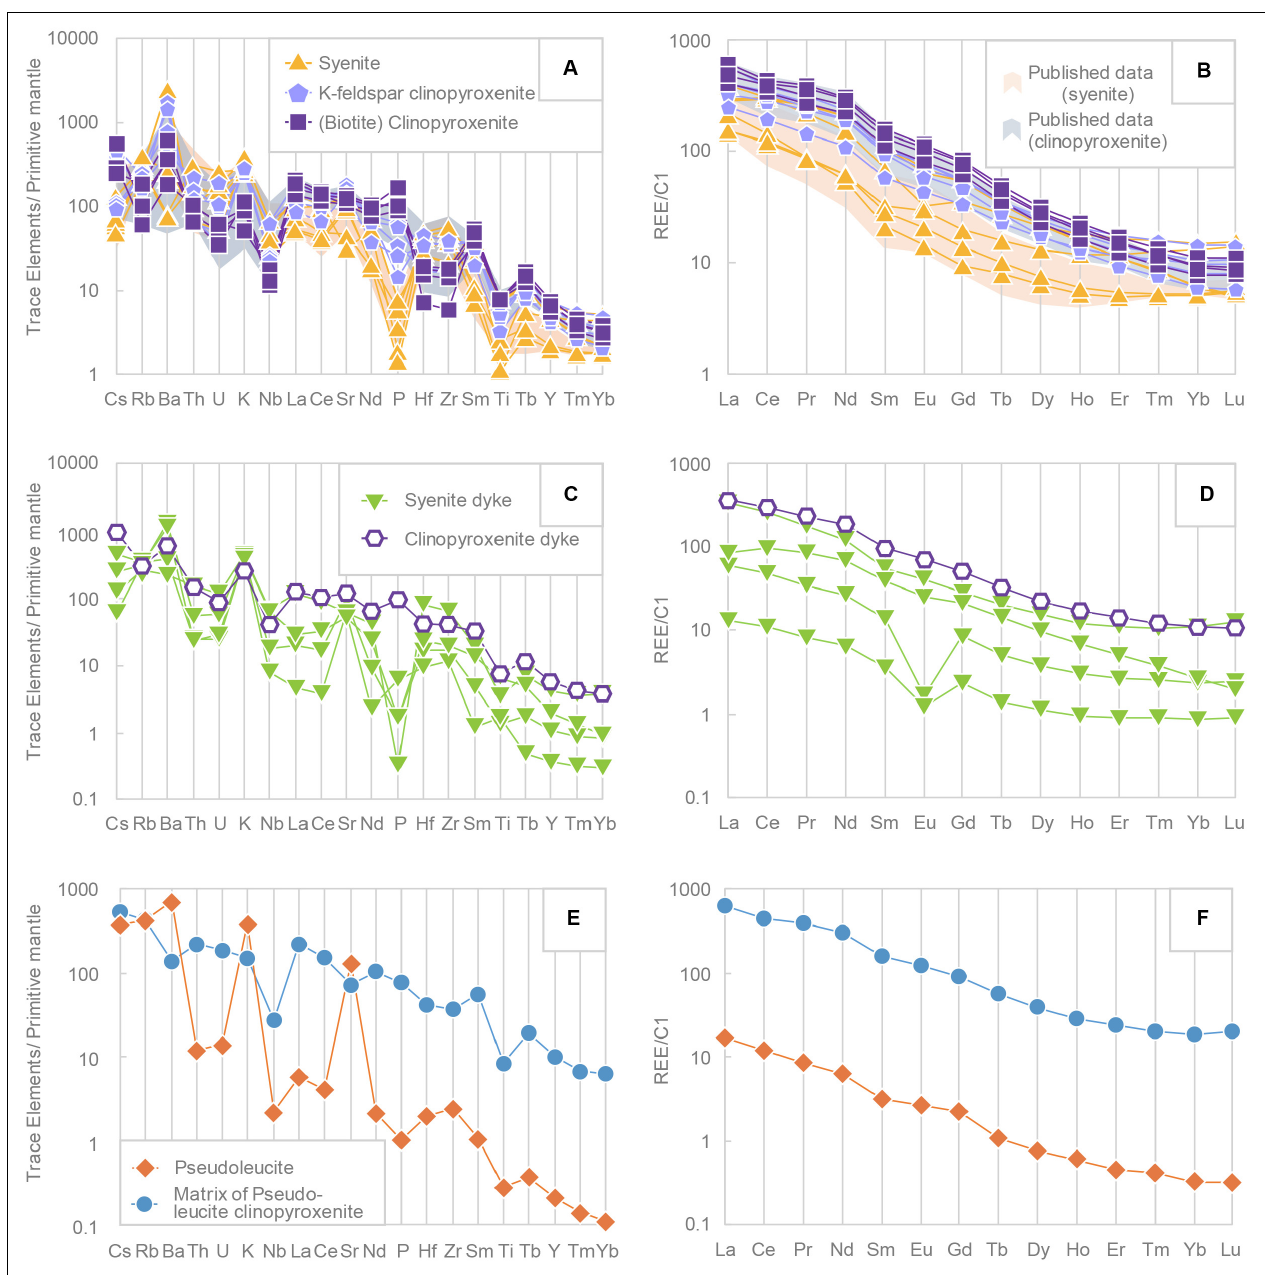
FIGURE 10 | Primitive mantle normalized trace element spider diagram of (A) syenite, (biotite) clinopyroxenite and K-feldspar clinopyroxenite; (C) syenitic and clinopyroxenitic dykes; (E) pseudoleucite and matrix of the pseudoleucite clinopyroxenite; chondrite normalized rare earth element (REE) pattern of (B) syenite, (biotite) clinopyroxenite and K-feldspar clinopyroxenite; (D) syenitic and clinopyroxene dykes; (F) pseudoleucite and matrix of the pseudoleucite clinopyroxenite. Published data of Yaojiazhuang complex are from Mu and Yan (1992) and Chen et al. (2013). The primitive mantle and C1 chondrite normalizing values are from Sun and McDonough